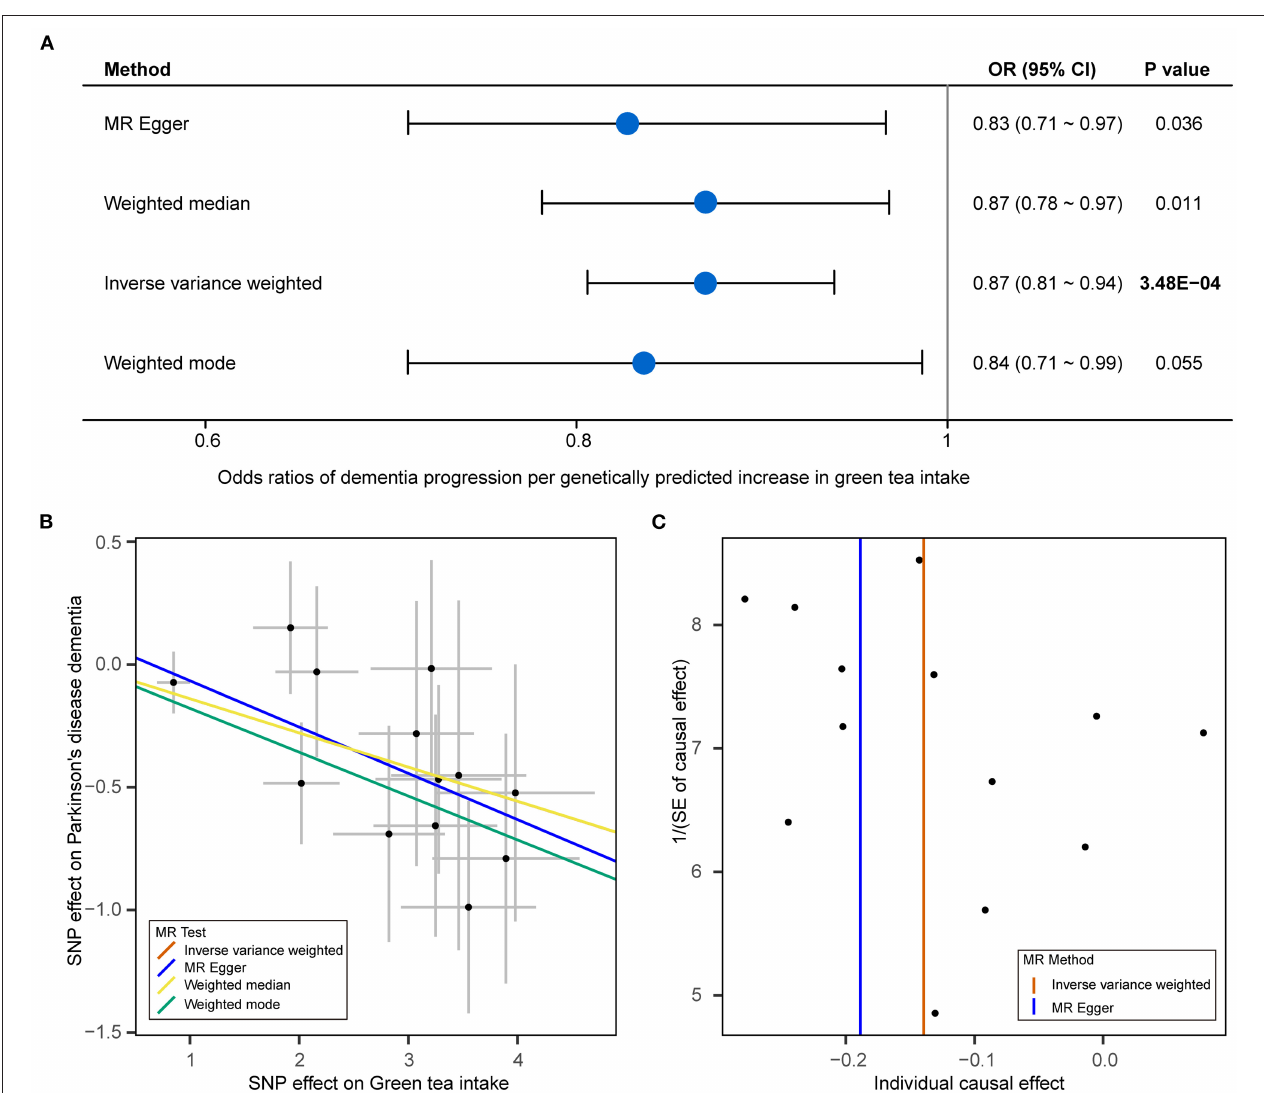
FIGURE 2 | Mendelian randomization analysis results for green tea intake and dementia of PD. (A) Forest plot showing Mendelian randomization (MR) analysis results to evaluate the causal association between green tea intake and progression to dementia using four methods. (B) Scatter plot of single nucleotide polymorphism (SNP) potential effects on green tea intake and dementia of PD. The 95% CI for the effect size on green tea intake is shown as vertical lines, while the 95% CI for the effect size on dementia of PD is shown as horizontal lines. The slope of fitted lines represents the estimated MR effect per method. (C) Funnel plot for green tea intake shows the estimation using the inverse of the standard error of the causal estimate with each individual SNP as a tool. The vertical line represents the estimated causal effect obtained using IVW and MR-Egger